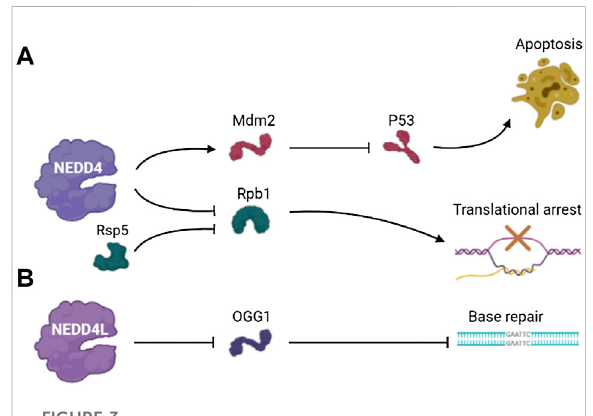
FIGURE 3 ThepathwaysinvolvedinDDRof (A) NEDD4and (B)